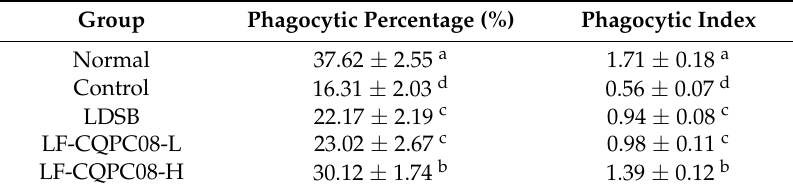
Table 3. Effect of Lactobacillus fermentum CQPC08 on phagocytosis of macrophages in mice with tongue cancer. Group